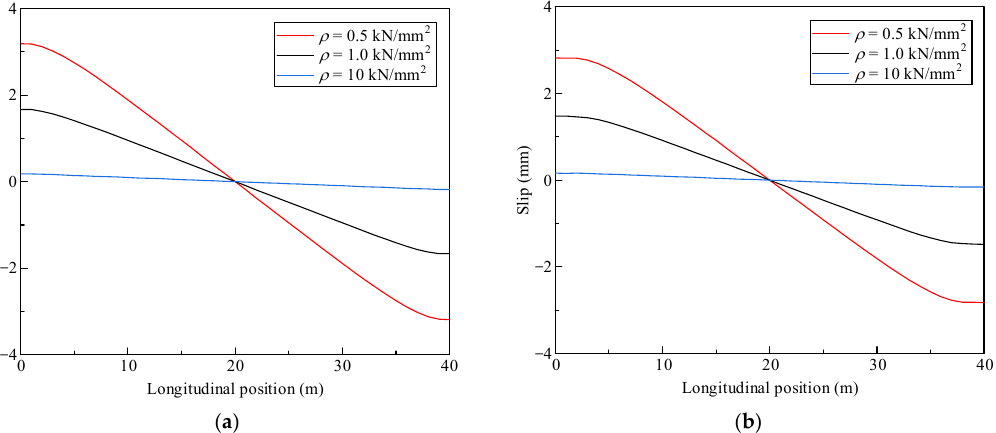
Figure 9. Vertical deflections of composite beams (influence of shear connection stiffness). ( a ) 28 days; ( b ) 3 years.